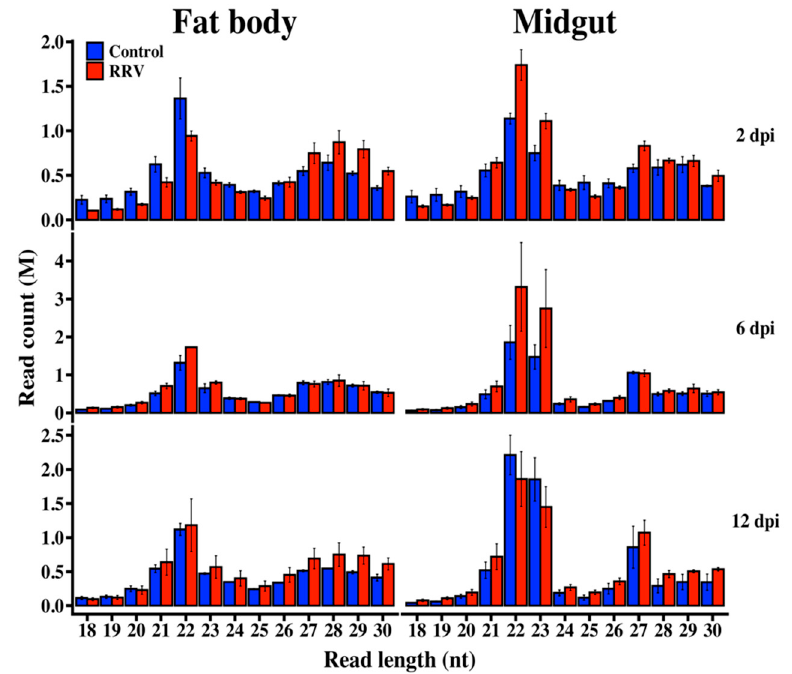
Figure 2. Length distribution of quality-filtered and adapter trimmed reads from Ae. aegypti fat body and midgut tissues at 2, 6, and 12 dpi. Error bars indicate the standard error of the mean of biological replicates ( N = 3).